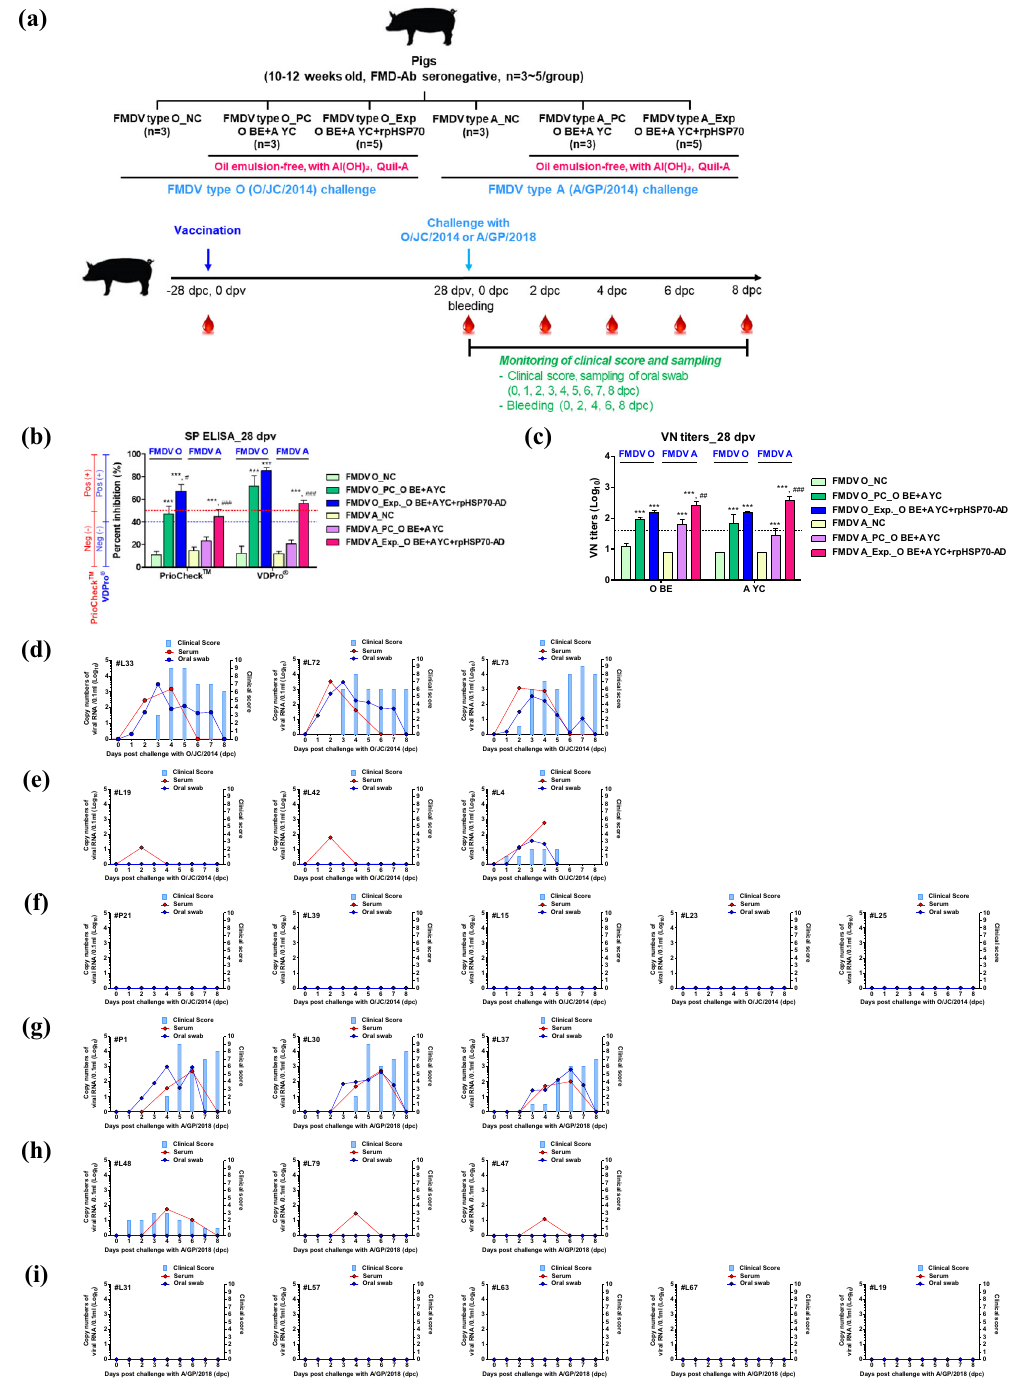
Fig. 7 rpHSP70-AD mediates host defense against FMDV O and A infection in pigs. For the challenge experiments, pigs (10 – 12 weeks old, n = 3 – 5/group) were administered oil emulsion-free test vaccines, including O BE + AYC antigen alone or combined O BE + A YC antigens with rpHSP70-AD. Vaccinated pigs were challenged with FMDV type O (O/SKR/JC/2014) or FMDV type A (A/SKR/GP/2018) on the heel bulb at 10 5 TCID 50 /100 μ L. Study strategy ( a ); SP O and SP A antibody titers ( b ); O/SKR/BE/2017 and A/SKR/YC/2017 VN titers ( c ); clinical score and the amount of virus in serum and oral swab from negative control ( n = 3/group) pigs against FMDV type O (O/SKR/JC/2014) ( d ) or FMDV type A (A/SKR/GP/2018) ( g ); clinical score and the amount of virus in serum and oral swab from positive control (O BE + A YC, n = 3/group) pigs against FMDV type O (O/SKR/JC/2014) ( e ) or FMDV type A (A/SKR/GP/2018) ( h ); clinical score and the amount of virus in serum and oral swab from experimental group (O BE + AYC + rpHSP70-AD, n = 5/group) pigs against FMDV type O (O/SKR/JC/2014) ( f ) or FMDV type A (A/SKR/GP/ 2018) ( i ). The left Y -axis of the graph shows the amount of virus in sera and oral swab as log 10 values; the right Y-axis shows the clinical index as the maximum value of 10 points. The data represent the mean ± SEM of triplicate measurements ( n = 3 ∼ 5/group). Statistical analyses involved two-way ANOVA with Bonferroni correction. *** p < 0.001: NC vs PC, NC vs Exp.; # p < 0.05; ## p < 0.01; ### p < 0.001: PC vs